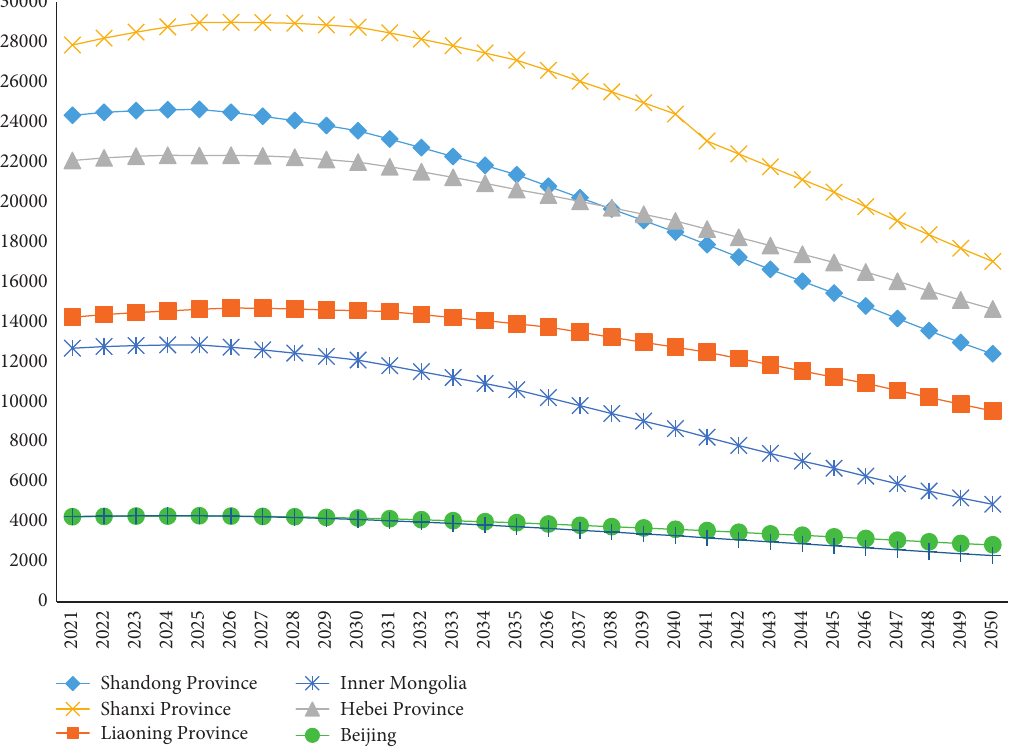
Figure 4: Carbon emissions of each province and city under the 2005–2020 scenario (unit: 10,000